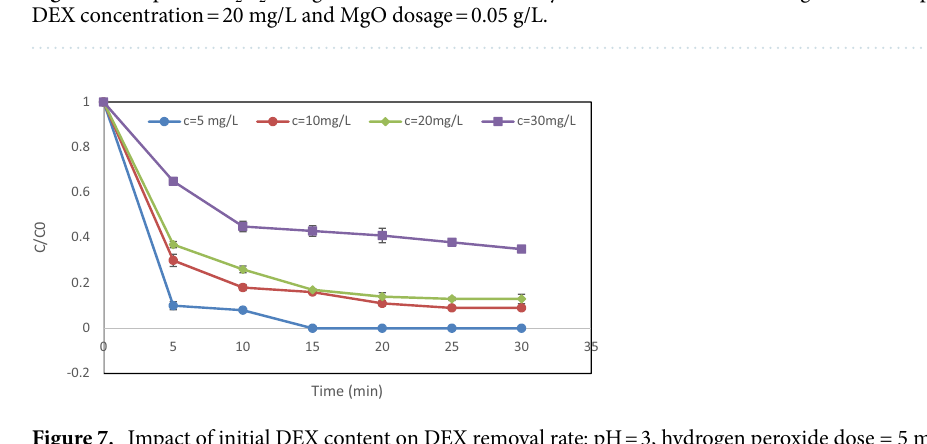
Figure 7. Impact of initial DEX content on DEX removal rate: pH = 3, hydrogen peroxide dose = 5 mM and MgO dose = 0.05